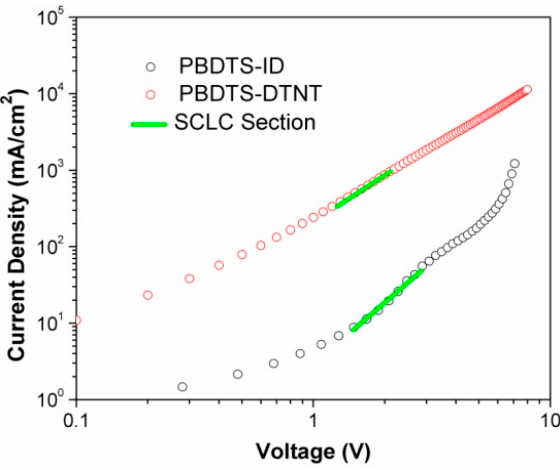
Figure 4. J - V curves of the hole-only devices under optimized conditions achieved by the space-charge-limited current (SCLC) method. Table 2. Photovoltaic performance of the polymer solar cells (PSCs) fabricated by using the configuration of indium-tin (PEIE)/polymer:PC 71 BM/MoO 3 /Ag.